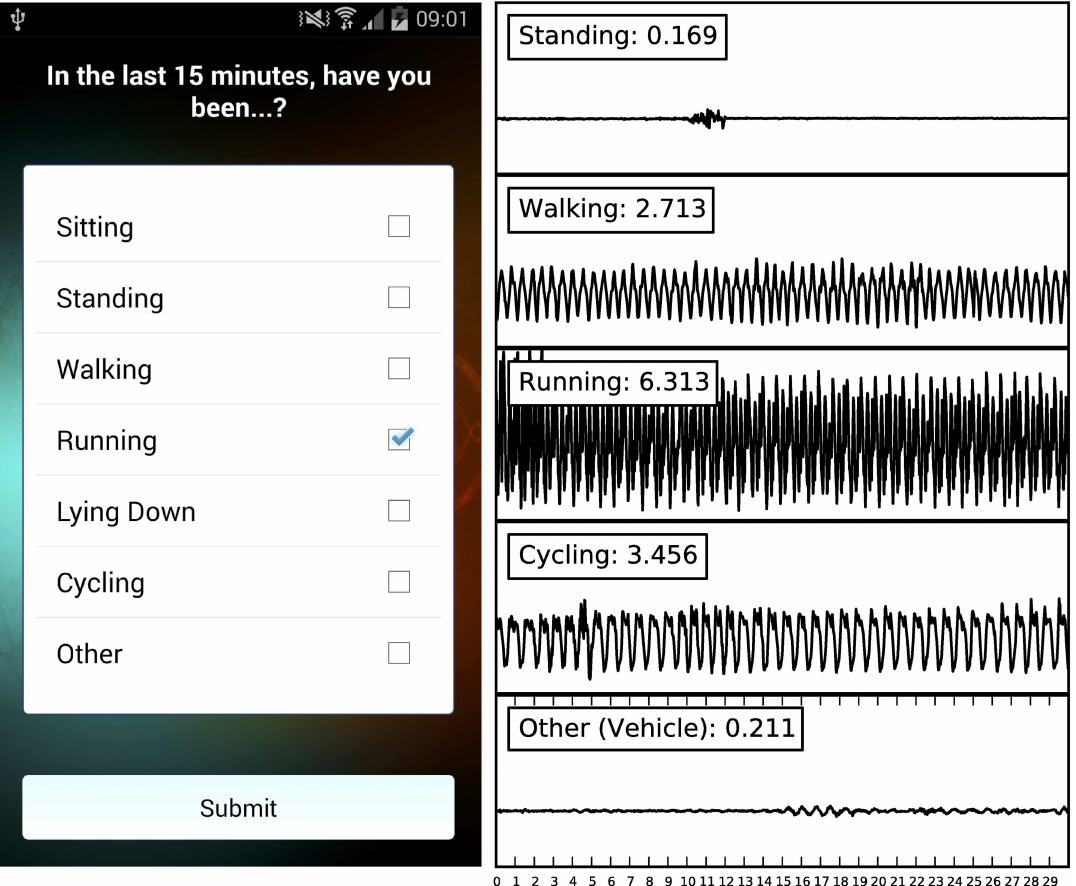
Fig 2. Physical Activity Data. From left to right: (a) How users self-report their recent physicalactivity, and (b) the magnitude of 30-second accelerometer samples collectedon one device whileperformingeach activity. The label (e.g., Walking: 2.713) containsthe value of the feature computedfrom the given accelerometer sample; more physicallydemanding activities result in highervalues.